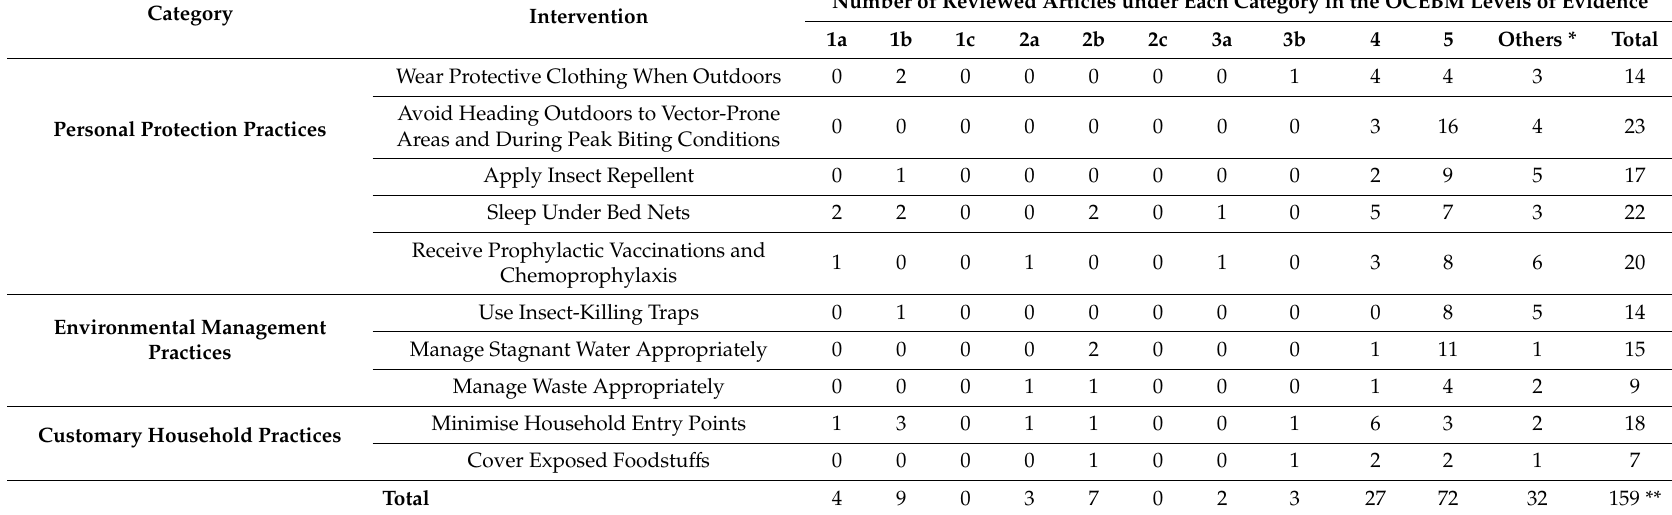
Table 5. Overview of Health-EDRM Primary Prevention Approaches against VBDs in the Reviewed Articles, Categorised by the Oxford Centre for Evidence-Based Medicine (OCEBM) Levels of Evidence. (Please see Table S1 for